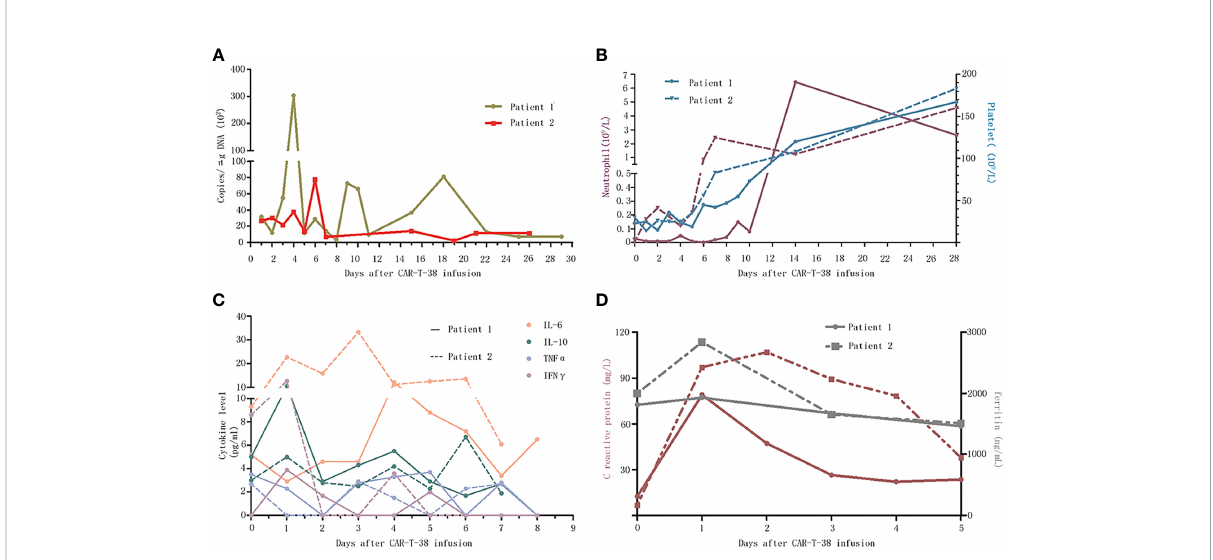
FIGURE 2 Dynamic changes after CAR-T-38 treatment. (A) The copies of CAR-T-38 cells in the peripheral blood measured by qPCR as the number of copies of lentiviral vector sequence per microgram of genomic DNA, which reached peak levels on days 4 and 6, respectively. (B) The neutrophil counts (left Y-axis) in patients 1 and 2 rose above 0.5 × 10 9 on days 14 and 7, respectively, and platelet counts (right Y-axis) of the two patients rose above 100 × 10 9 on day 14. (C) This part showed the changes of cytokines including IL-6, IL-10, TNF a , and IFN g concentrations after CAR-T-38 infusion. (D) This part showed the changes of c-reaction protein (left Y-axis) and ferritin (right Y-axis) concentrations after CAR-T-38